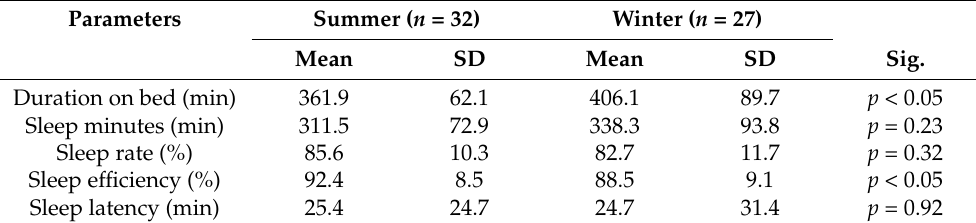
Table 4. Sleep parameters.